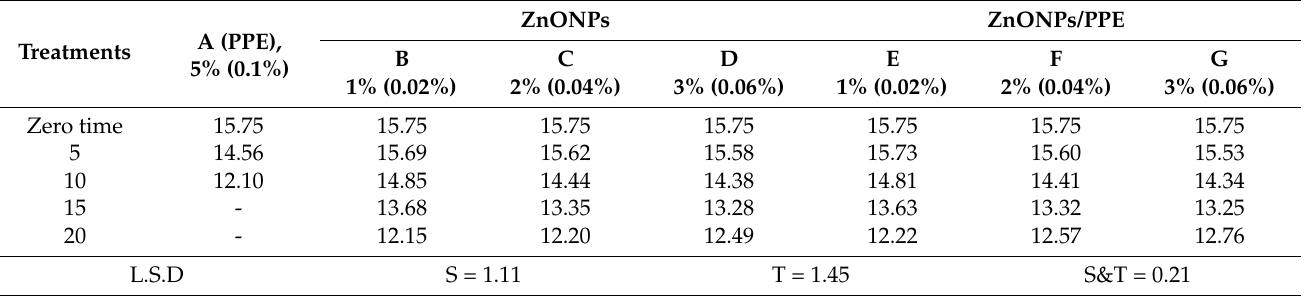
Table 7. Effect of edible film and coatings on total soluble solids (TSS) of manfalouty pomegranate during storage at 2 ◦ C.